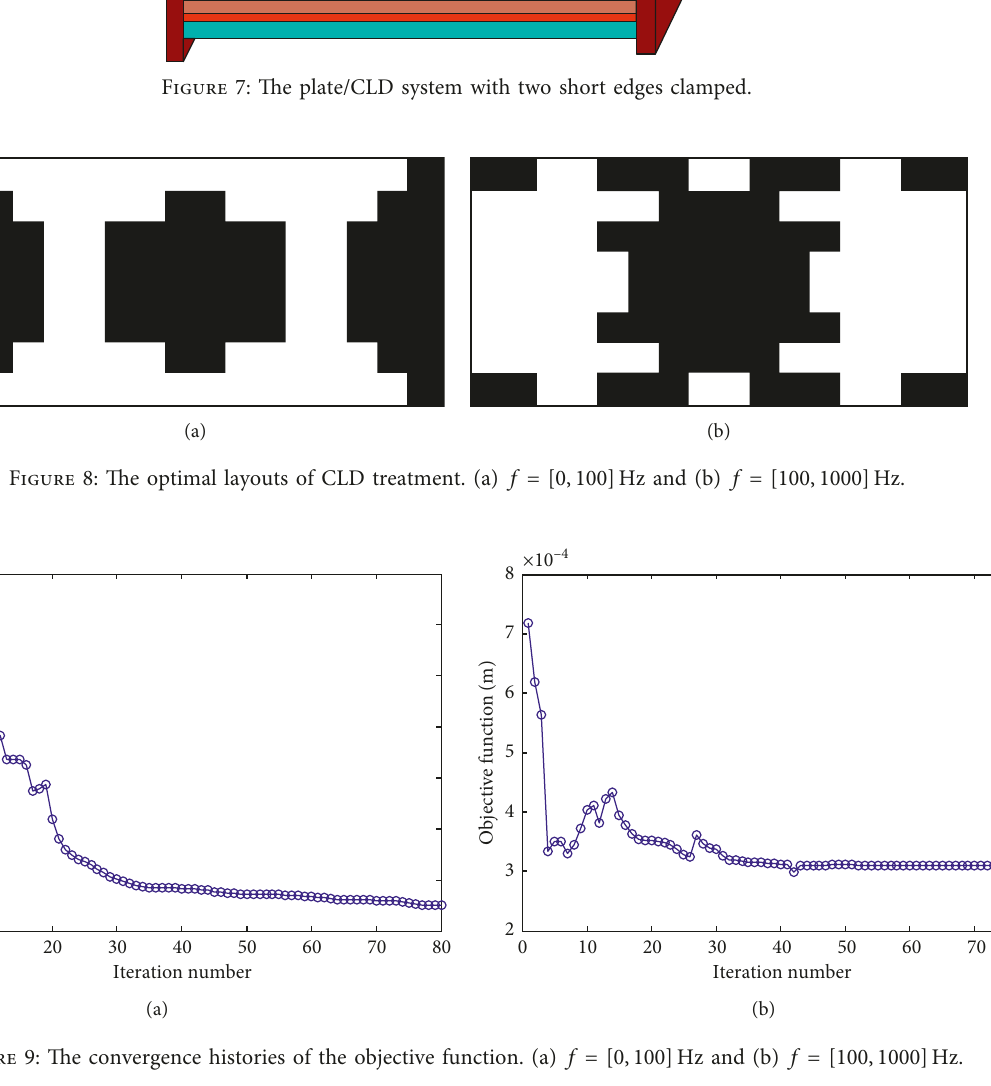
0 , 100 Hz and (b) f 100 , 1000 Hz. (cid:31) [ ] (cid:31) [ ]